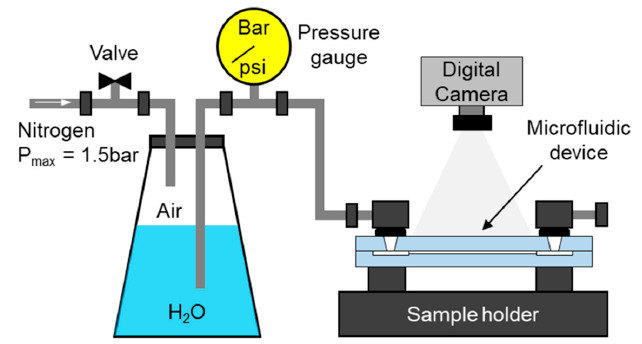
Figure 4. Set-up used for testing the laser-manufactured microfluidic devices.